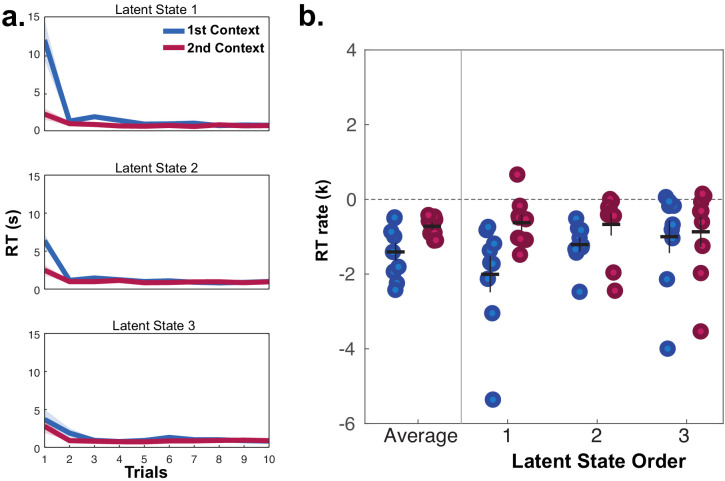
Reaction times (RT) for participants in the behavioral group who passed the generalization criterion in session 2 (N = 9) during mini-blocks during generalization in session 2, organized by the presentation of latent states (LS 1, 2, 3) and contexts (first and second).Participants were significantly slower on the first trial of mini-blocks when encountering the first context in a LS compared to the second context in the same LS, but not in subsequent trials. (a) RT curves for mini-blocks organized by the order of LSs and contexts encountered. Lines indicate means, shaded area indicates the SEM. (b) Rates of exponential functions fit to these RT curves. Each dot represents a participant. Horizontal bars indicate the mean and vertical bars the SEM.